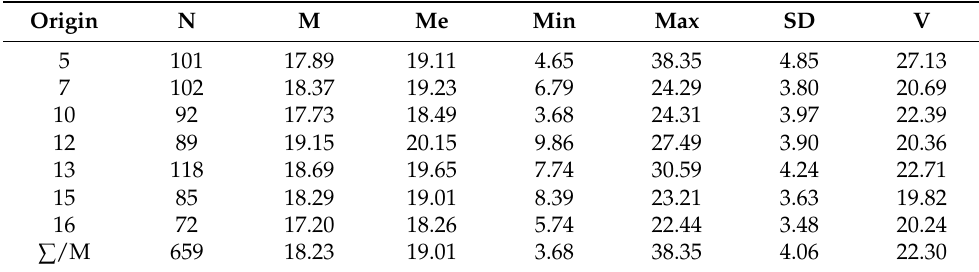
Table 6. Characteristics of JRg (km) of diverse genetic origins (N—Number of groups; M— Average; Me—Median; Min—Minimum; Max—Maximum; SD—Standard deviation; V—Coefficient of variation).